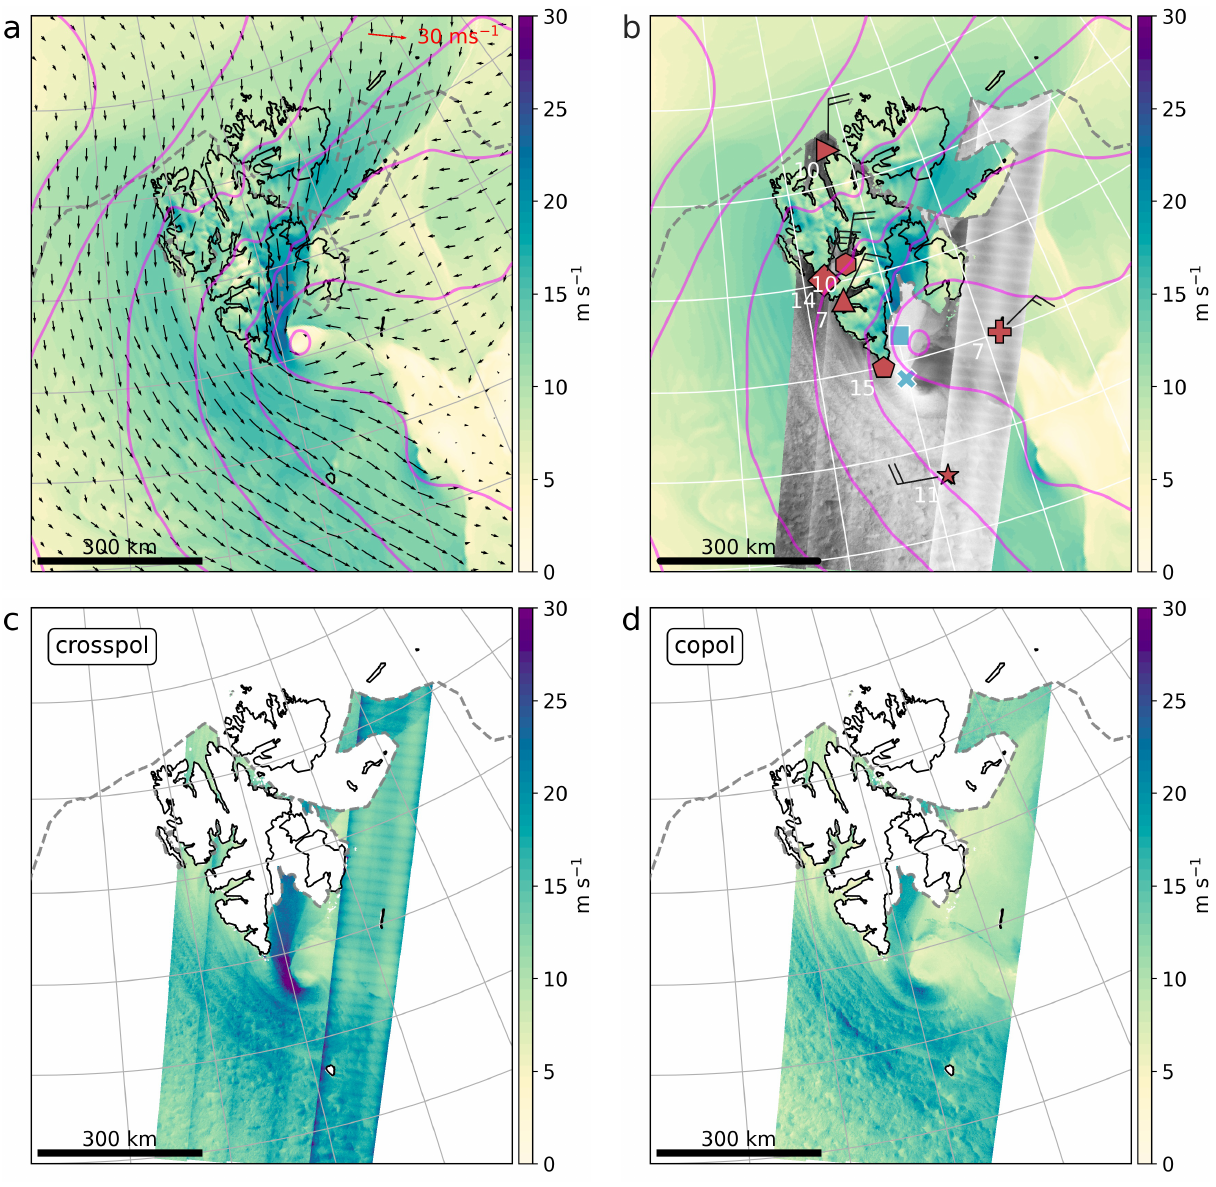
Figure 2. AROME-Arctic model simulation as well as weather station observations and Sentinel-1 crosspol SAR backscatter of an example polar low at 06 UTC 26 December, 2018, close to the archipelago of Svalbard. ( a ) AROME-Arctic wind field at 10m AGL (arrows and colour shading in ms − 1 ) and isobars of sea level pressure (magenta contour lines with 4-hPa increments). The dashed, grey line shows the sea ice edge (sea ice concentration = 0) and indicates the boundary of the area within which ice-contaminated SAR observations were removed. ( b ) as in ( a ), but overlaid with ground weather stations (red station symbols with black wind barbs and white wind speed in ms − 1 ) and SAR crosspol backscatter intensities (grey shading in dB, bright indicates high values). The blue square and x symbols indicate the areas of maximum wind speed simulated by the AROME-Arctic model and the crosspol retrieval. ( c , d ) show retrieved wind speed (colour shading in ms − 1 ) from two established wind retrievals that use the crosspol backscatter, and a combination of copol backscatter and the a priori wind direction of the AROME-Arctic model,